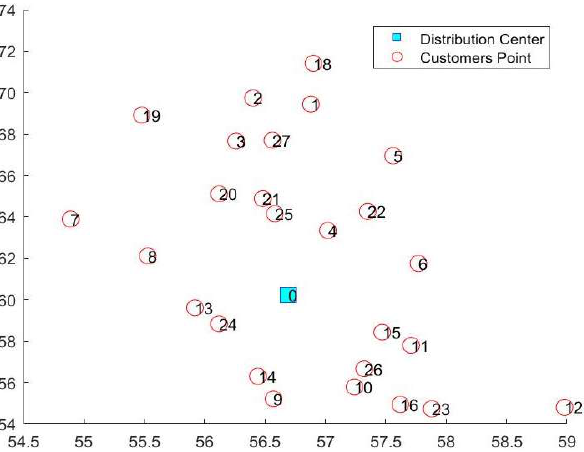
Figure 6. The distribution map of the customer points and distribution centers. Table 4. The delivery vehicle model parameter table.